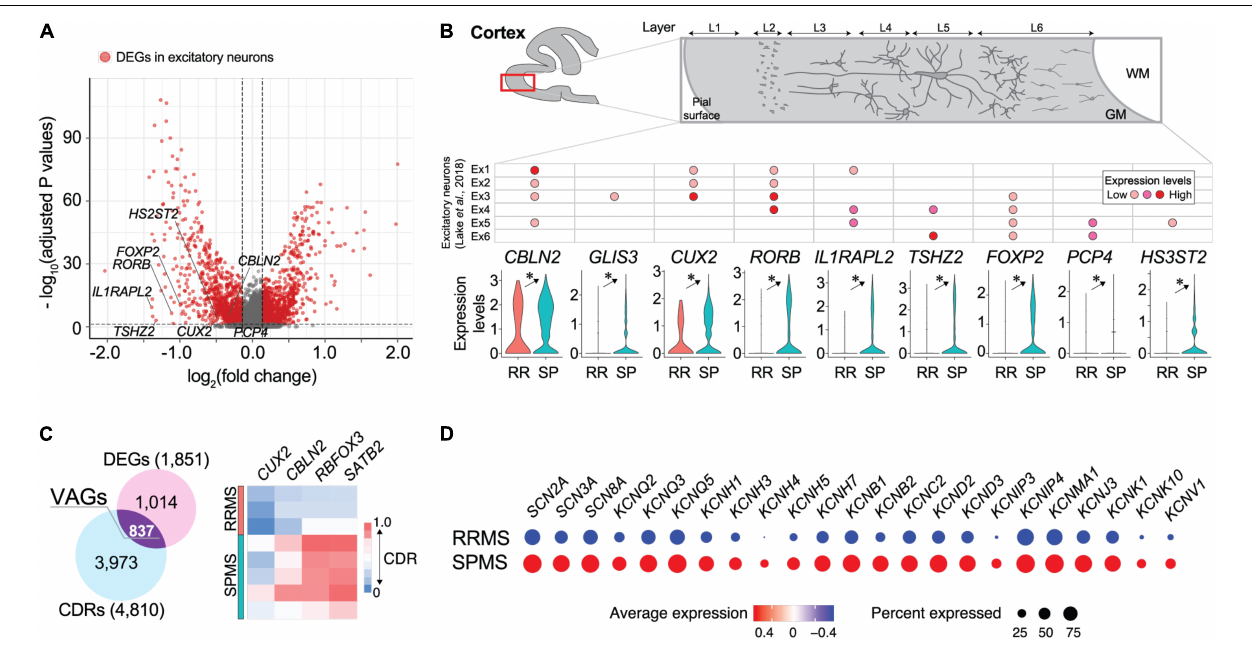
FIGURE 2 | Transcriptomic divergence in neuronal populations between RRMS vs. SPMS. (A) Volcano plots of genes identified in excitatory neurons. Red dots represent differentially expressed genes (DEGs; adjusted p -values < 0.05 and fold change > 1.1) and gray dots represent non-significant genes. (B) Violin plots of excitatory neuron marker gene expression levels and a table for their expression patterns in the cortical layer determined by previous study (Lake et al., 2018). ∗ , adjusted p -value < 0.05. (C) Venn diagram of DEGs and genes of differential CDRs (cell detection rates; the proportion of cells that express particular genes within each cell cluster), and a heatmap of excitatory neuron marker genes found in VAGs (vastly altered genes). (D) Dot plots of expression levels of sodium and potassium channel genes. Size and color indicate CDRs and expression levels, respectively. Statistical data for DEGs, CDRs, and VAGs are provided in Supplementary Tables 4–6